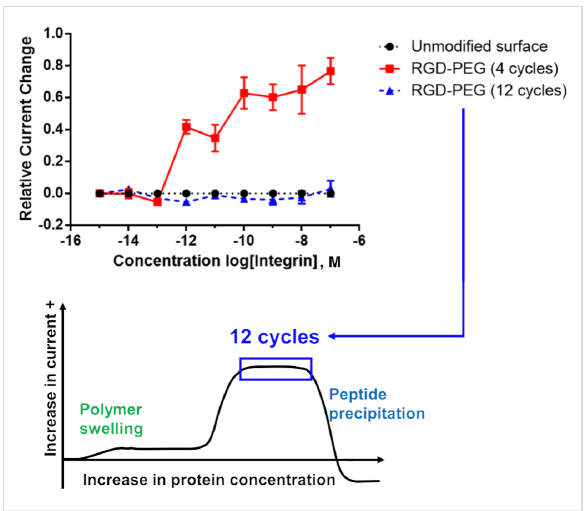
Figure 7: Four cycles vs. twelve cycles and the effect on binding curve location.